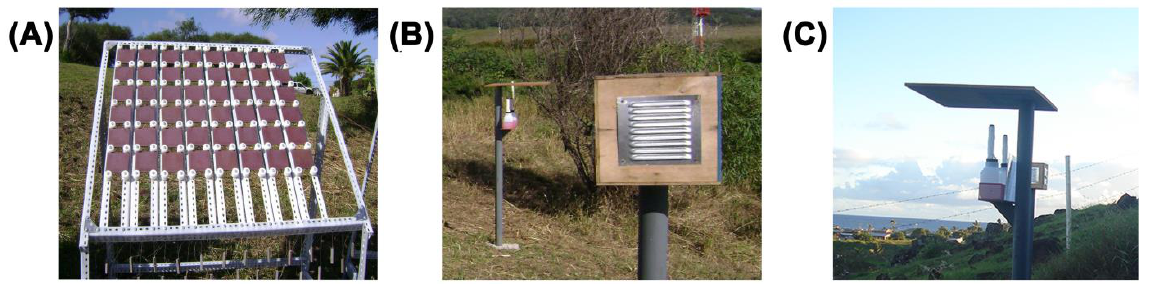
Figure 2. ( A ) Frame containing the copper specimens on Rapa Nui, ( B ) candles for the determination of SO 2 , and ( C ) candles for the determination of